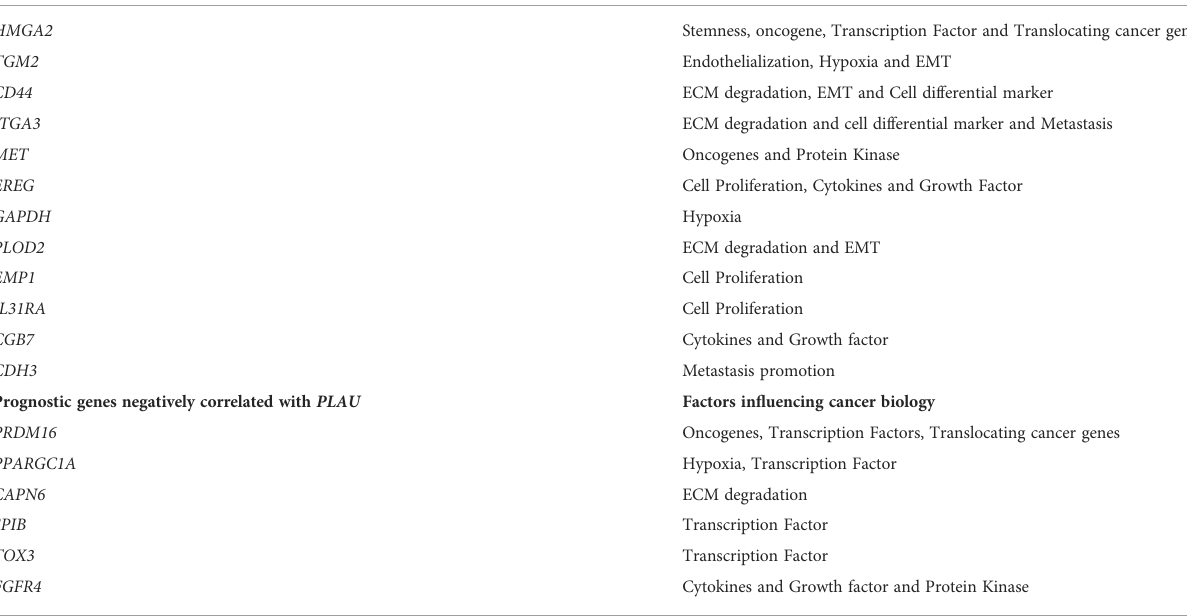
TABLE 1 PLAU correlated genes and their association with cellular functions in PDAC. Prognostic genes positively correlated with